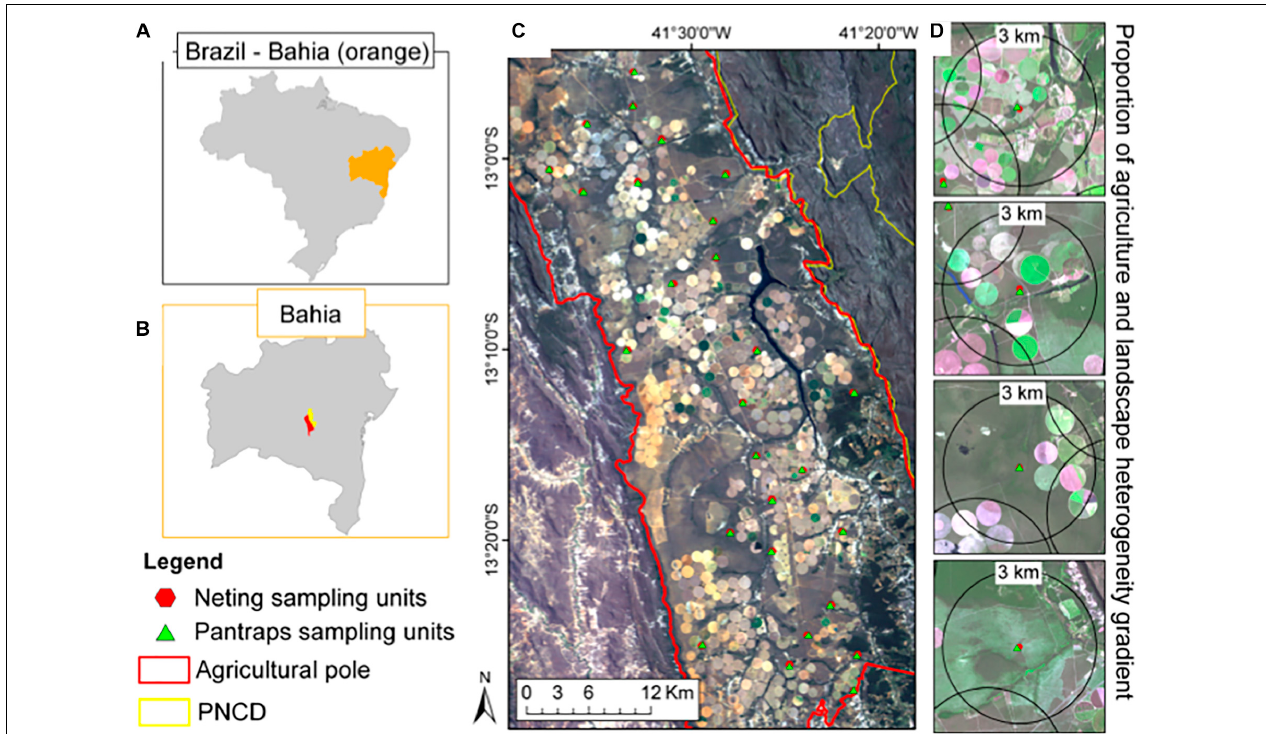
FIGURE 1 | (A) Highlighted in orange and light gray, the state of Bahia and Brazil, respectively. (B) At the center of the state of Bahia (red), the studied region, with the lands of the agricultural partnership in red and Chapada Diamantina National Park in yellow. (C) Location of the 27 selected sampling units (red dots and green triangles) in the study region and the land cover classification used for the calculation of landscape metrics. (D) Example of the 3-km buffer used for the selection of sampling units. Modified from Moreira et al.